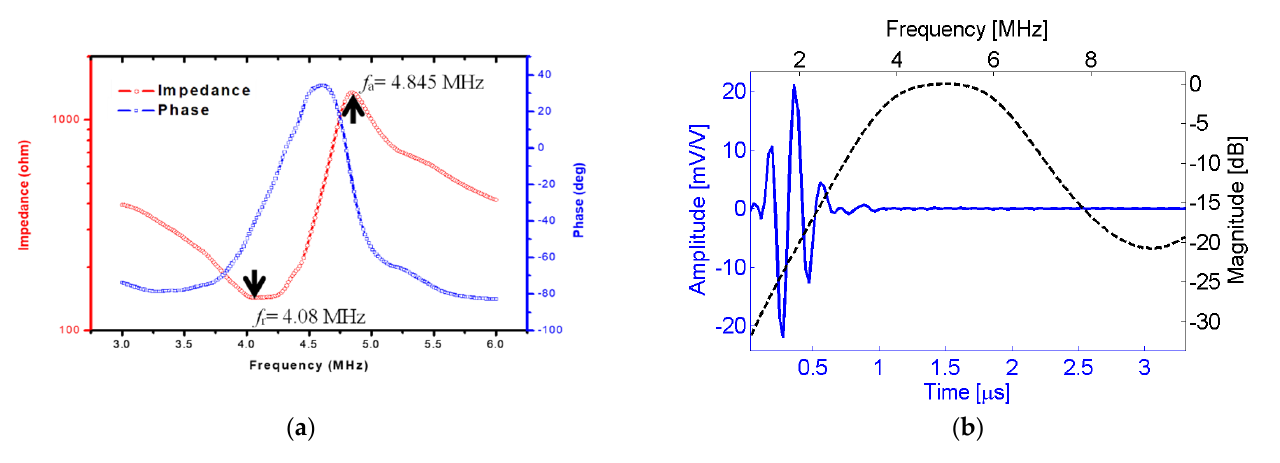
Figure 4. ( a ) Resonance and anti-resonance peaks; ( b ) pulse–echo response of 2-2 composite fabricated by magnetic force-assisted self-assembly.